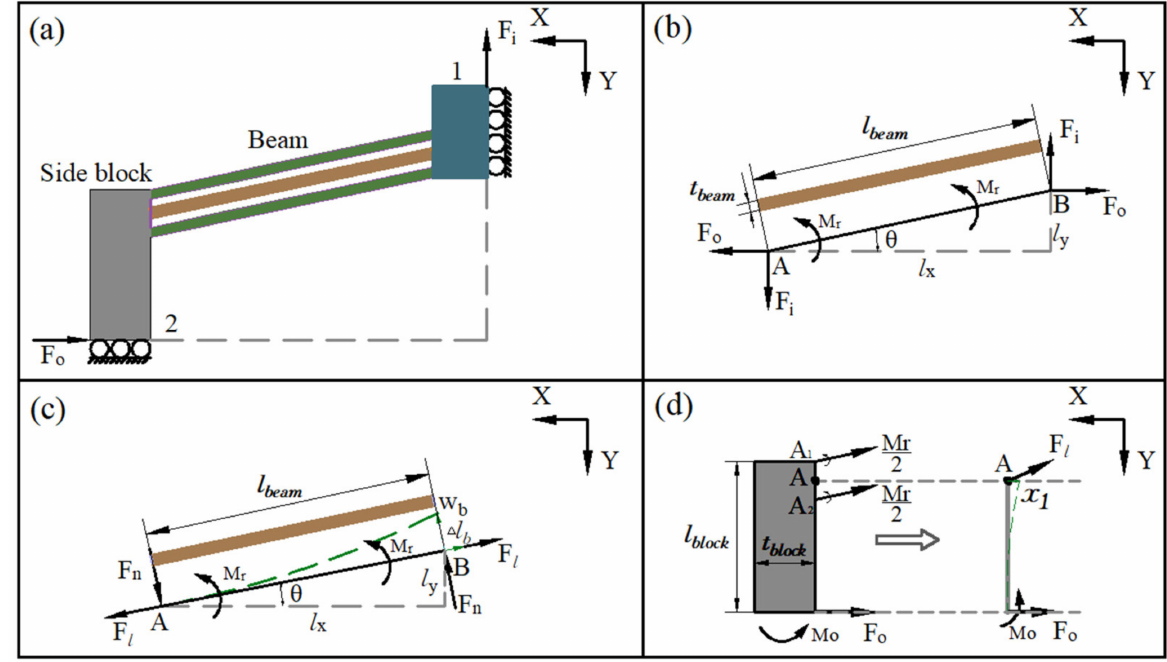
Figure 6. Structural and mechanical analysis of a single rhombus amplified frame. ( a ) Quarter frame structure; ( b ) Bridge-type beam force analysis; ( c ) Bridge-type beam deflection deformation; ( d ) Side block force and simplified